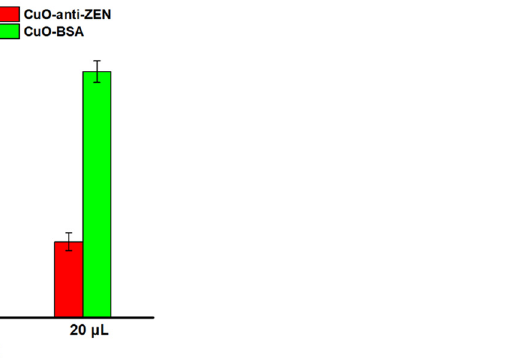
Figure 2. Specific and nonspecific reaction between CuO NP-anti-ZEN/CuO NP-BSA and MB-BSA-ZEN.